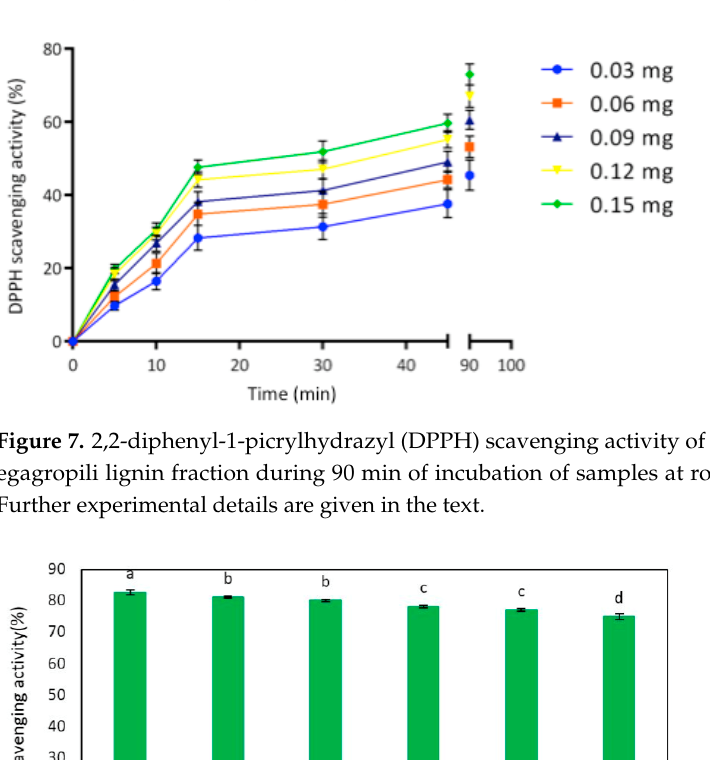
Figure 7. 2,2-diphenyl-1-picrylhydrazyl (DPPH) scavenging activity of different concentrations of egagropili lignin fraction during 90 min of incubation of samples at room temperature and dark. Further experimental details are given in the text.